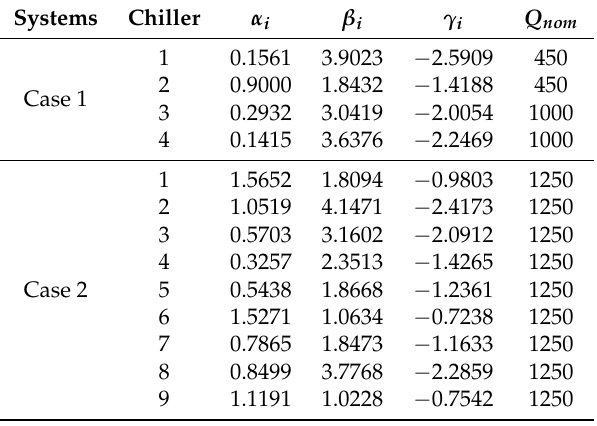
Table A1. Coefficients of chillers’ COP-PLR curves.